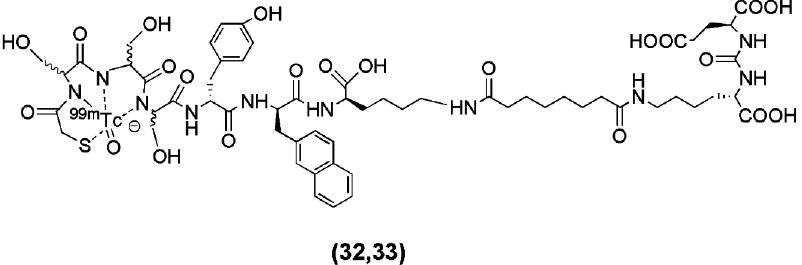
Figure 8. Chemical structure of 99m Tc-MAS 3 ( 32 )/mas 3 ( 33 )-y-nal-k-Sub-KuE (MAS 3 /mas 3 - D -Tyr- D -2- Nal- D -Lys-suberoyl-Lys-urea-Glu) [101].